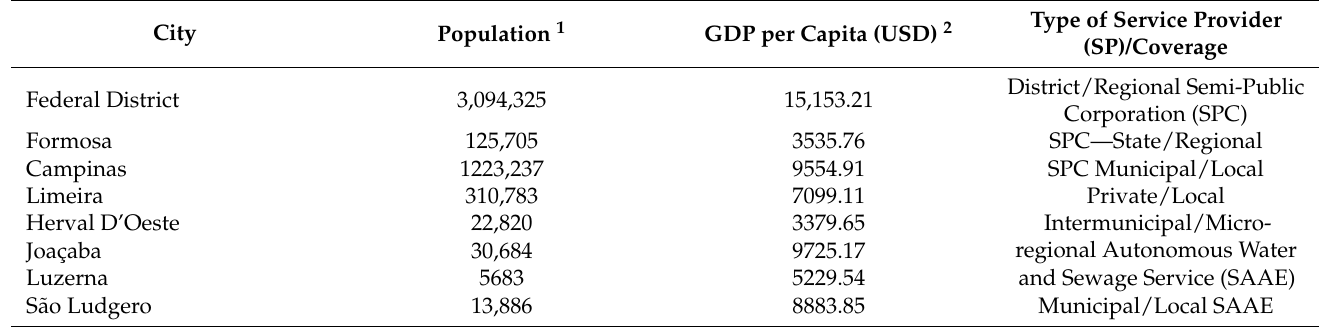
Table 4. Characteristics of the federative entities whose service providers have implemented WSPs in their